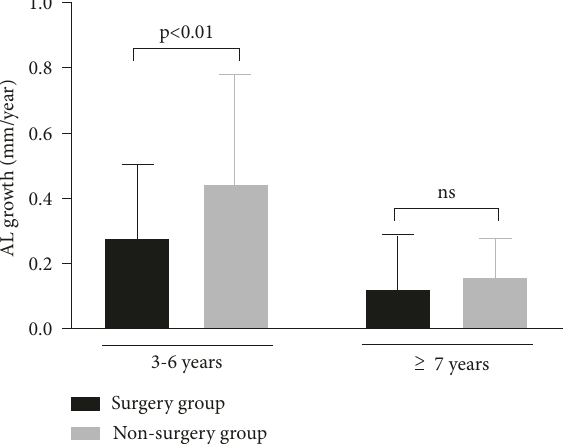
Figure 5: Comparison of the growth rate of axial length in the surgery group and the nonsurgery group of CEL